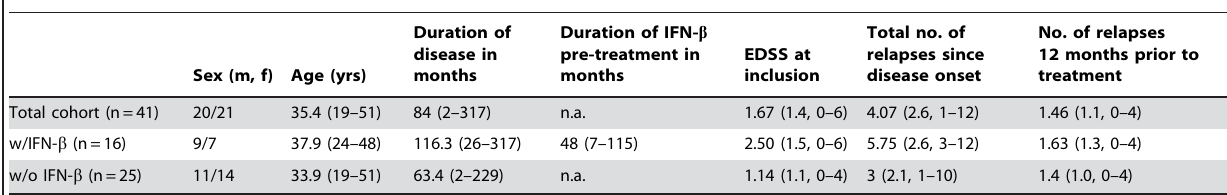
Table 1. Clinical and demographic baseline data of